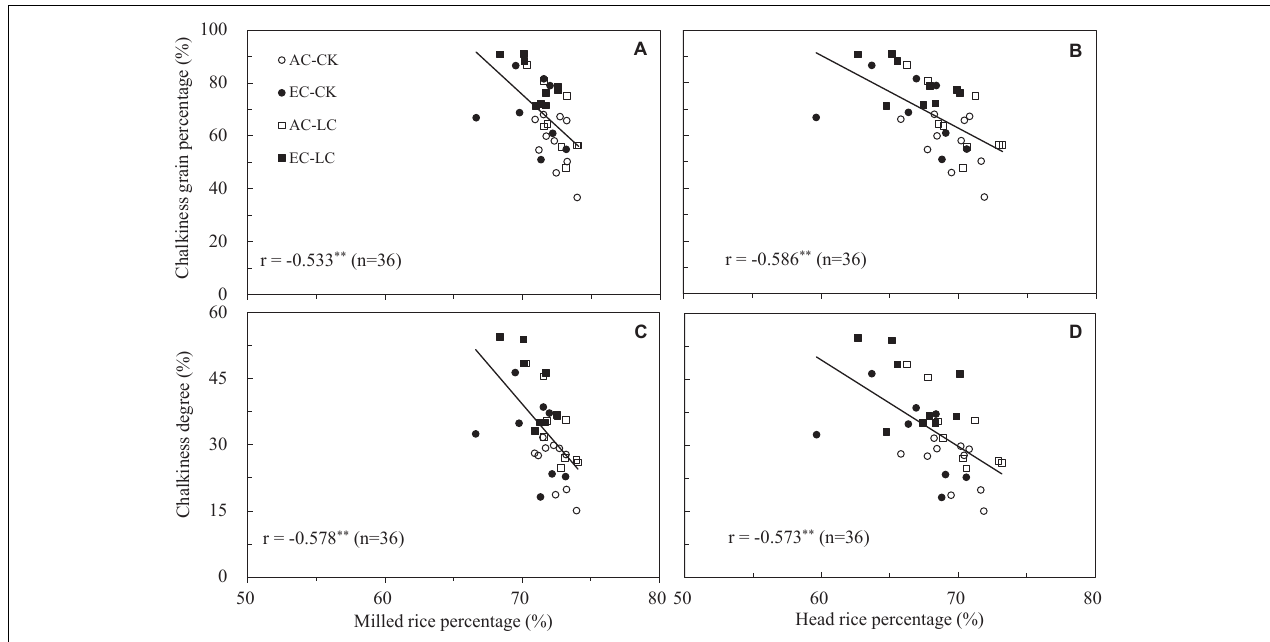
FIGURE 6 | Relationship between chalkiness grain percentage and milled rice percentage (A) , chalkiness grain percentage and head rice percentage (B) , chalkiness degree and milled rice percentage (C) , chalkiness degree and head rice percentage (D) for each combination of year × CO 2 × LC × plot in 2016-2018. AC, ambient CO 2 ; EC, elevated CO 2 (AC + 200 ppm). CK, no leaf cutting; LC, cutting off top three leaves. Statistically significant effects are indicated as ∗∗ P <